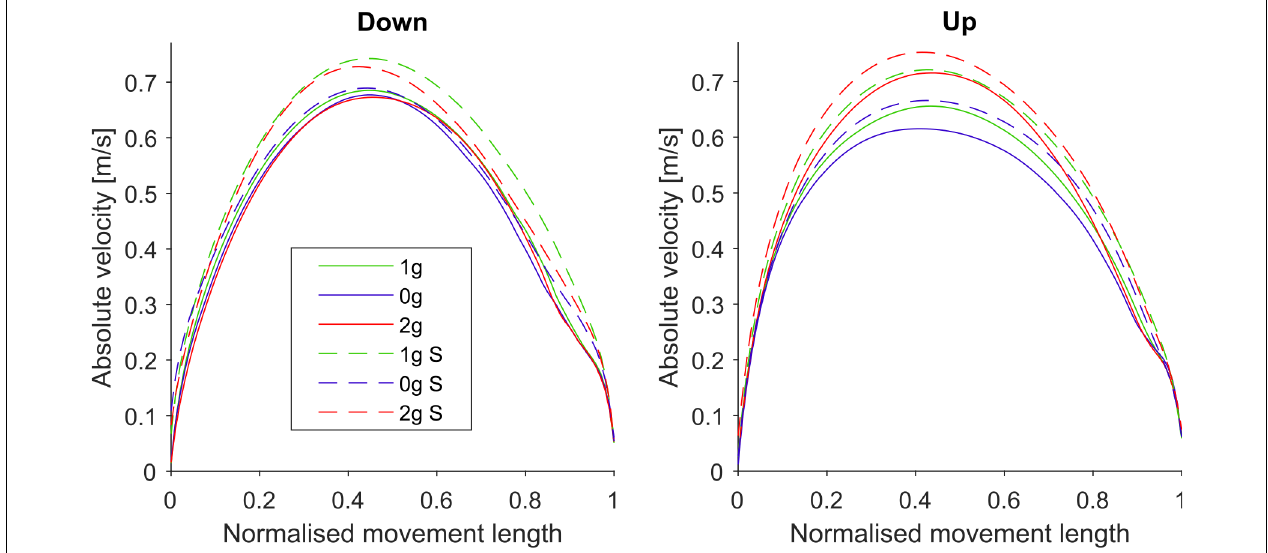
FIGURE 4 | Mean velocity profiles for downward and upward movements in all conditions. Solid lines represent the conditions during flight (1g, 0g, 2g) whereas dashed lines represent the simulated conditions (1g S, 0g S, 2g S). Green represents normogravity, blue represents microgravity and red represents hypergravity conditions.